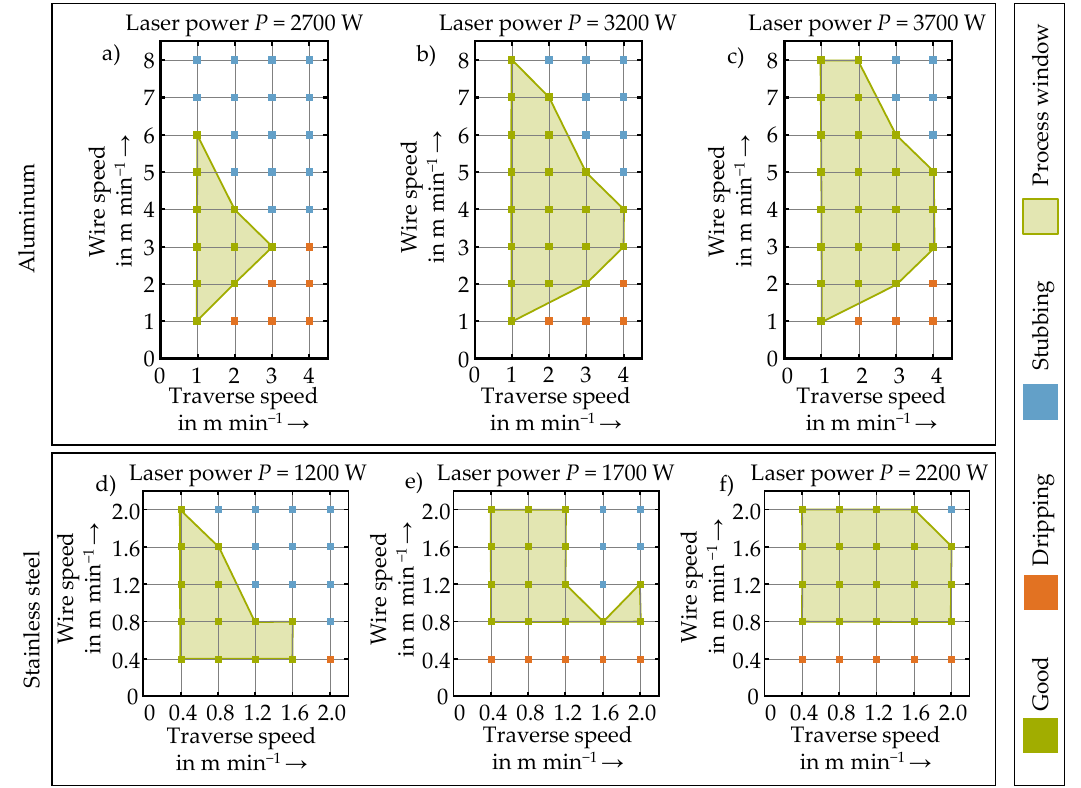
Figure 6. Determined process maps for aluminum ( a – c ) and stainless steel ( d – f ); the values of the fixed laser powers are indicated on top of the respective diagrams.